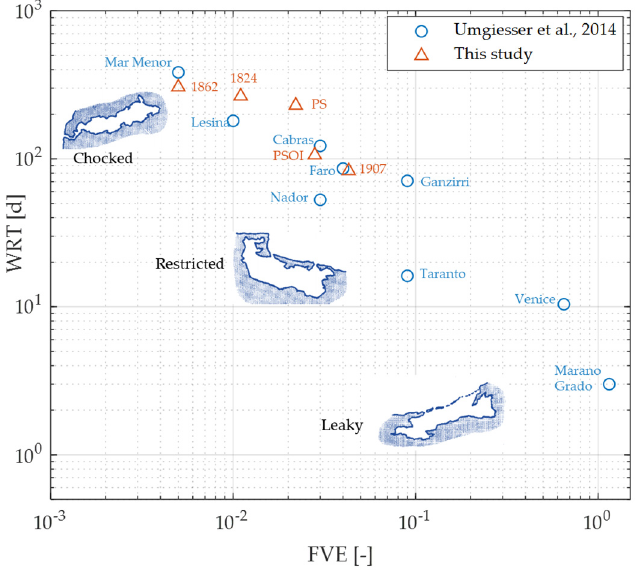
Figure 11. Classification of the Orbetello Lagoon in the different past and present scenarios based on water residence time WRT and fraction of the total water volume daily exchanged with the sea FVE, and comparison with similar results obtained in Umgiesser et al. [42].